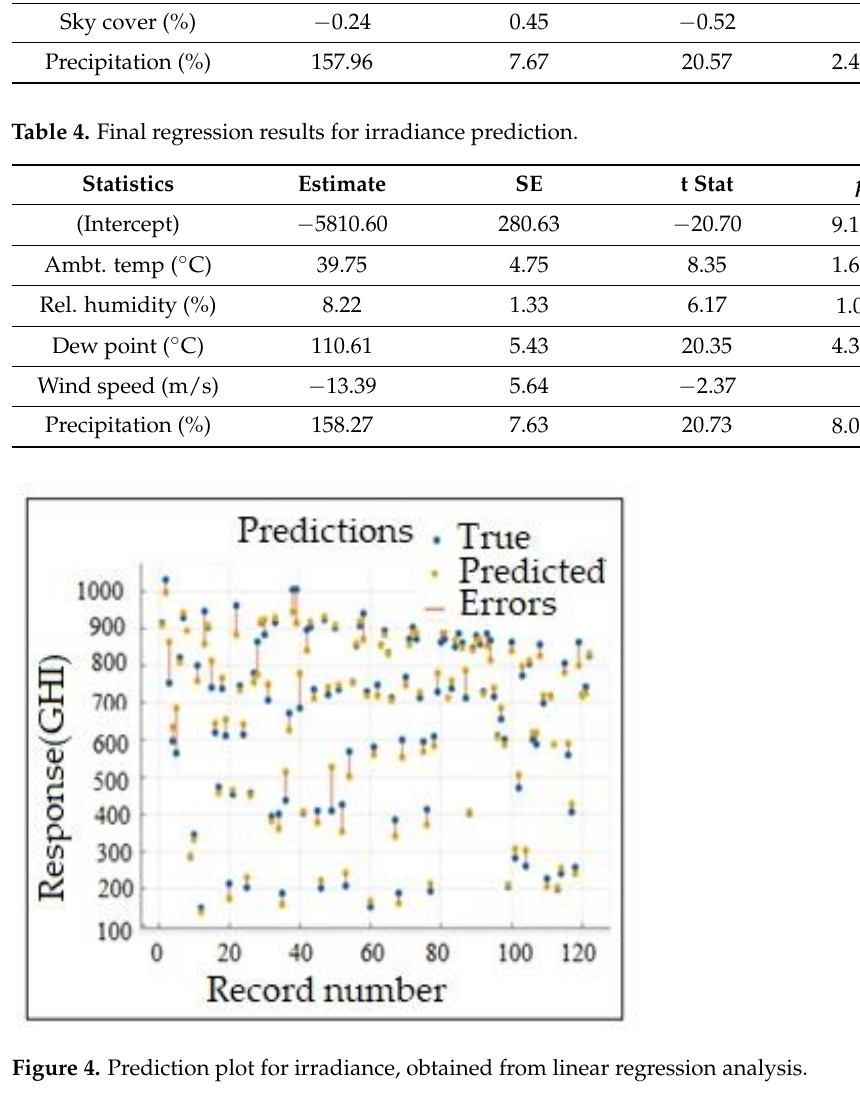
relative error is between 16% and − 26%, with the majority of values being less than